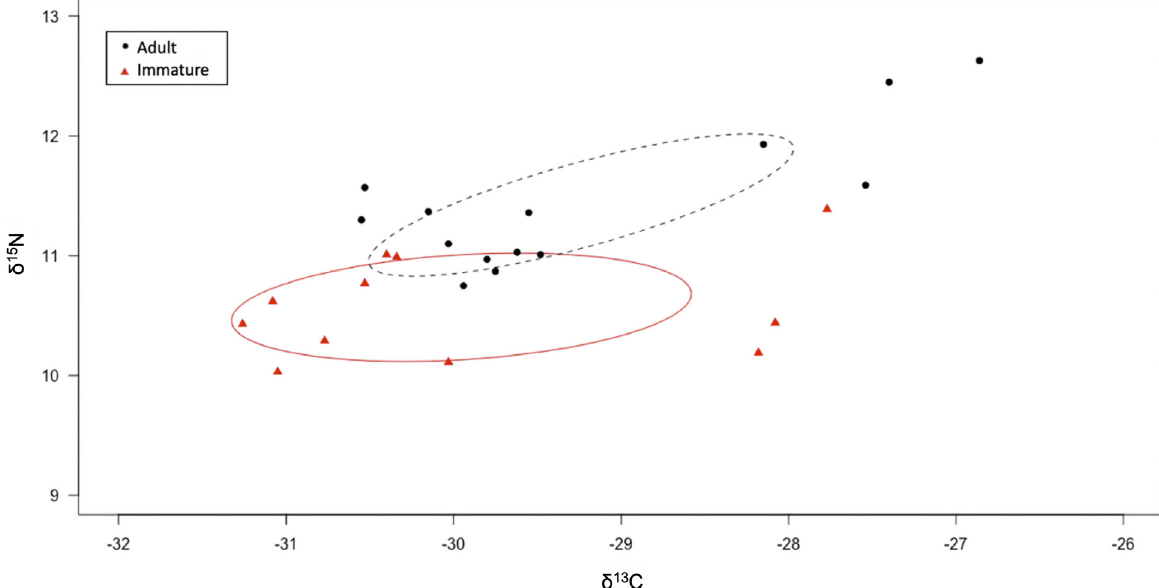
Figure 3. Stable isotopes values of carbon (δ 13 C) and nitrogen (δ 15 N) and Standard Ellipses Areas (SEAc) for immature (red solid ellipse) and adult (black dashed ellipse) individuals of the non-native piranha Serrasalmus marginatus